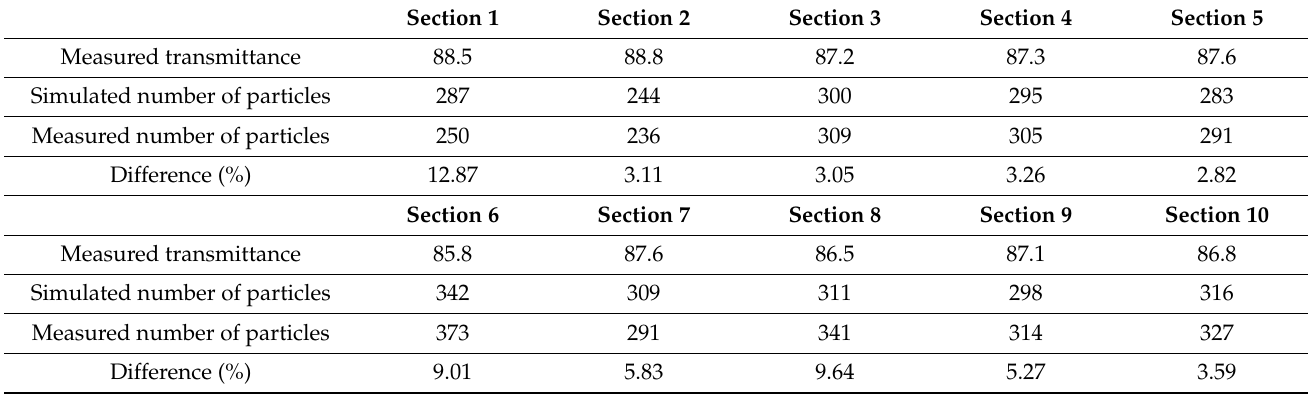
Figure 12. Automated measurement result of light transmittance after 3.5 days of dust deposition.